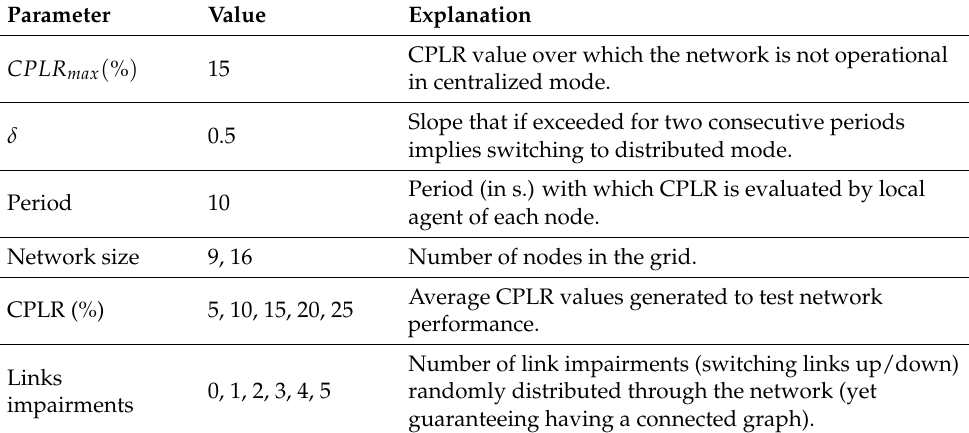
Table 1. The experimental parameters and their corresponding